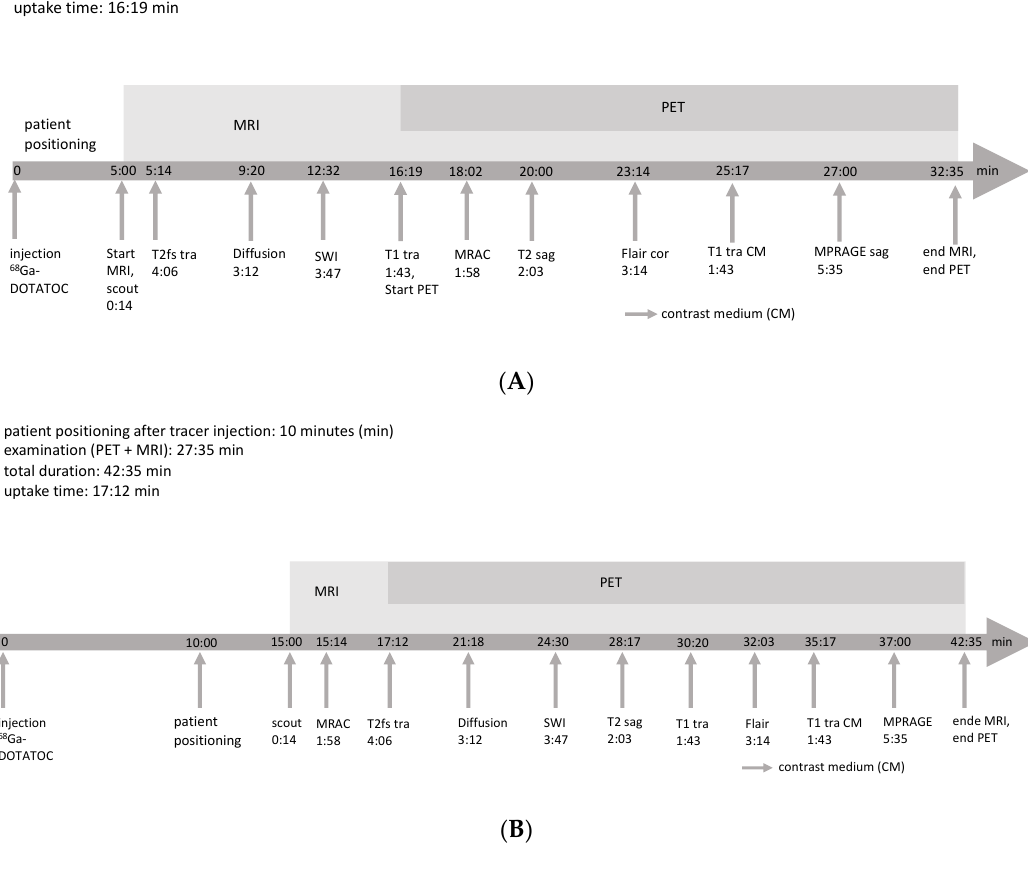
Figure 6. Adjusted protocol for Ga-68-DOTATOC-PET/MRI in our clinic. ( A ) Examination of the first patient of the day; ( B ) examination of the following patients. SWI, susceptibility-weighted imaging; MRAC, MRI-based attenuation correction; FLAIR, fluid-attenuated inversion recovery; MPRAGE, magnetization-prepared rapid acquisition with gradient echo; T2fs, T2-weighted sequences with fat saturation; tra, transaxial plane; sag, sagittal plane; cor, coronal plane; CM. gadolinium-based contrast medium.